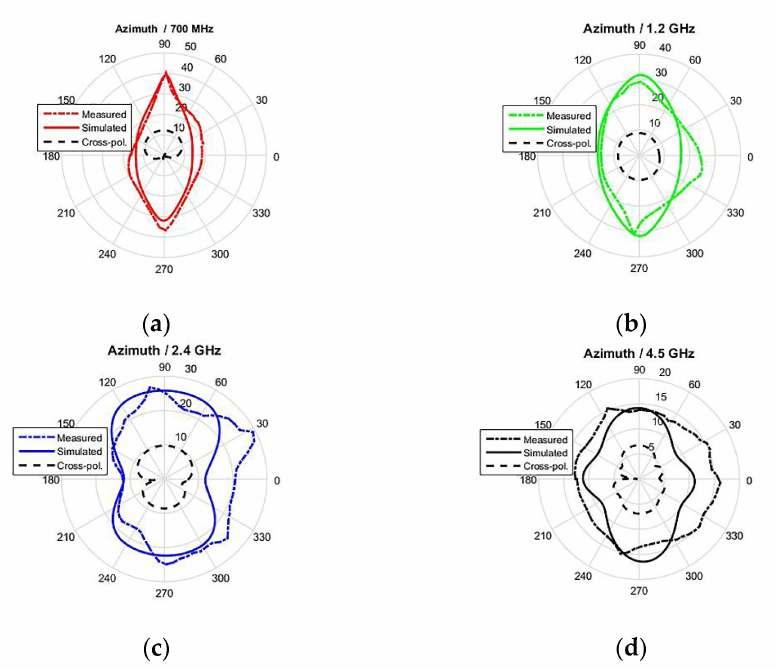
Figure 16. H-plane radiation pattern at: ( a ) 0.7 GHz; ( b ) 1.2 GHz; ( c ) 2.2 GHz; ( d ) 4.5